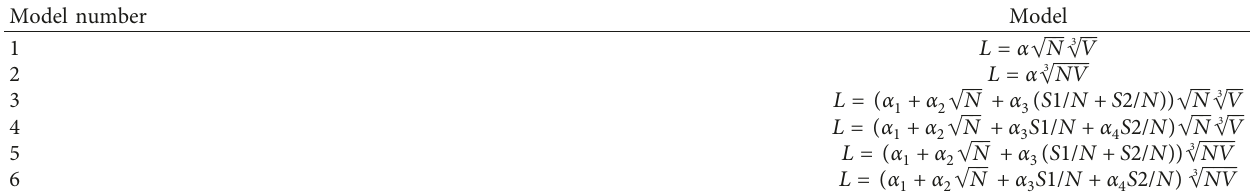
Table 7: Proposed regression models.